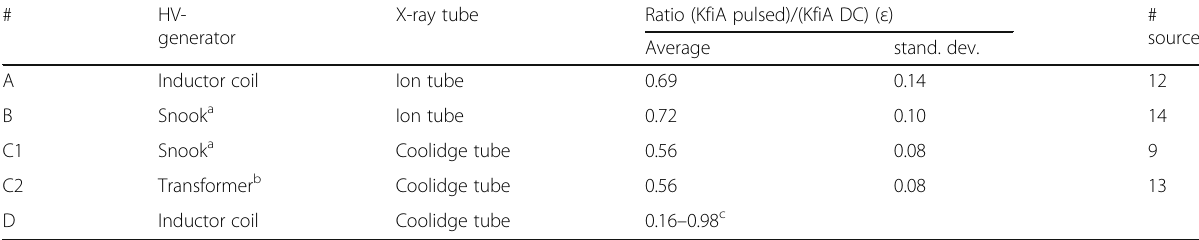
Table 3 Different combinations of HV-generator and X-ray tube and their X-ray efficiency ε